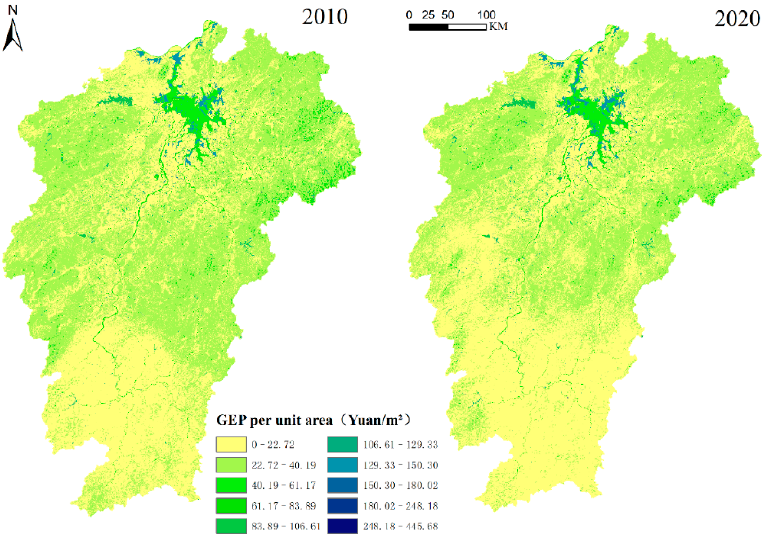
Figure 4. Spatial distribution of GEP per unit area in Jiangxi Province in 2010 and 2020.